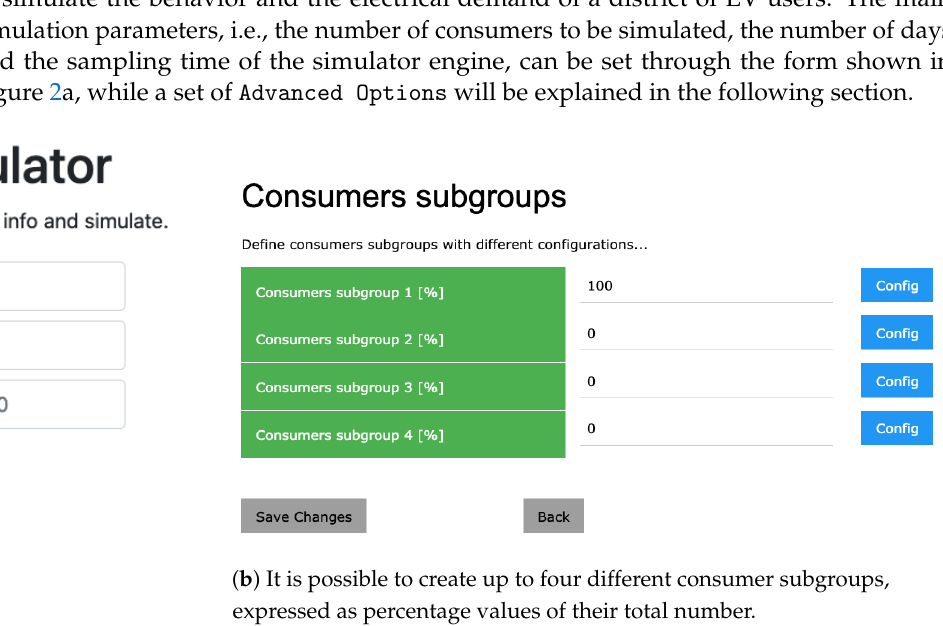
Figure 2. Initial steps of the online simulation